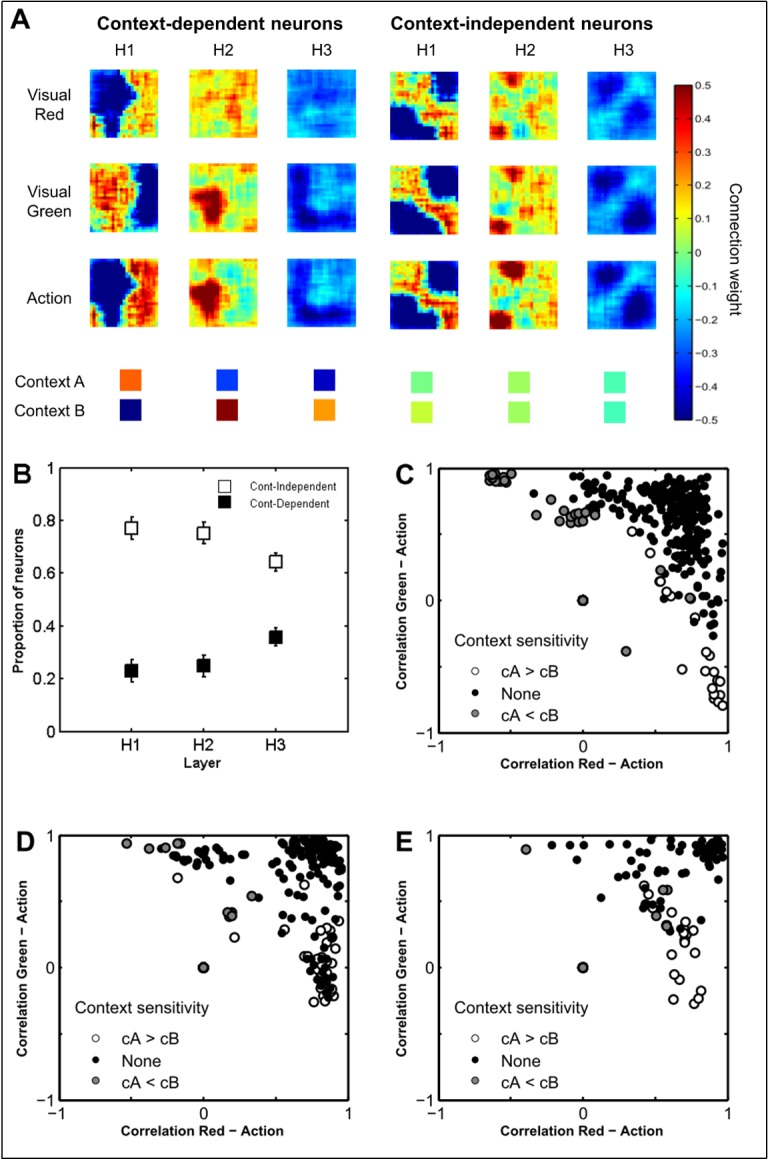
Receptive fields of the network's neurons.(A) Receptive fields of representative neurons in the first (H1), second (H2), and third (H3) hidden layers, belonging to the context-dependent and context-independent classes, respectively. Panel B: average proportion of context-dependent and context-independent neurons in the three hidden layers. (C-E) Correlations between the receptive fields of the two visual inputs and the action input computed for each neuron in the first (C), second (D), and third (E) hidden layer of the first replication of the neural network. Each data point represents a neuron and is depicted in a colour that indicated whether it is sensitive to context A or B, or none.